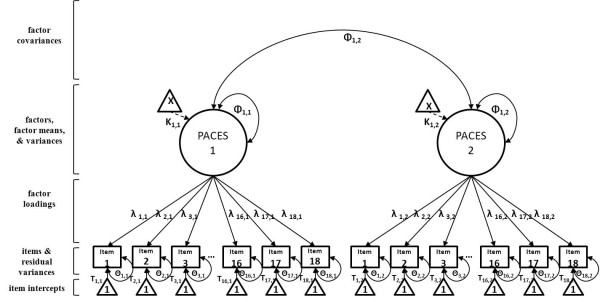
Model Parameters Involved in Testing Invariance of 8-item PACES.